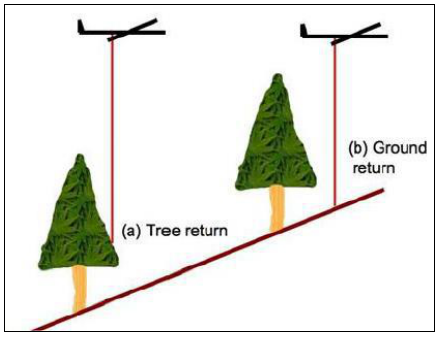
Figure 1. The illustration for impact of slope towards the accuracy of LiDAR data (Lewis and Hancock, 2007).